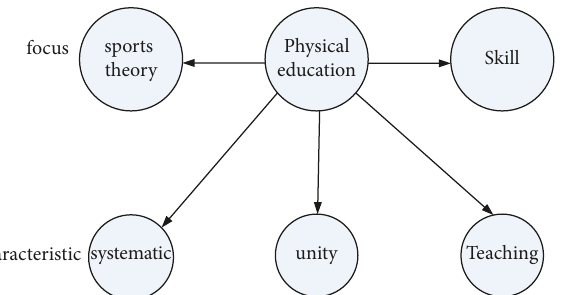
Figure 3: Emphasis and characteristics of physical education